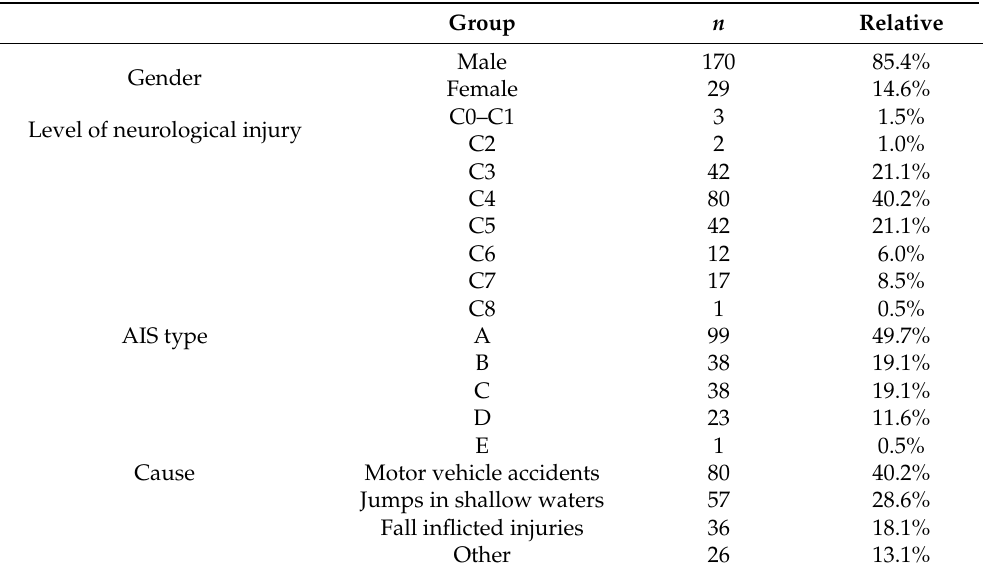
Table 1. Details on the demographics and injury characteristics at